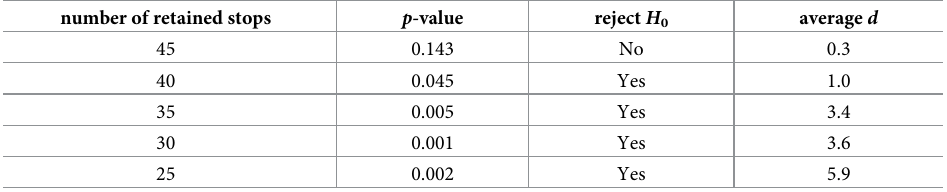
Table 4. p -values from the Wilcoxon signed-rank test on the 30 synthetic instances with the significance level α = 0.05.